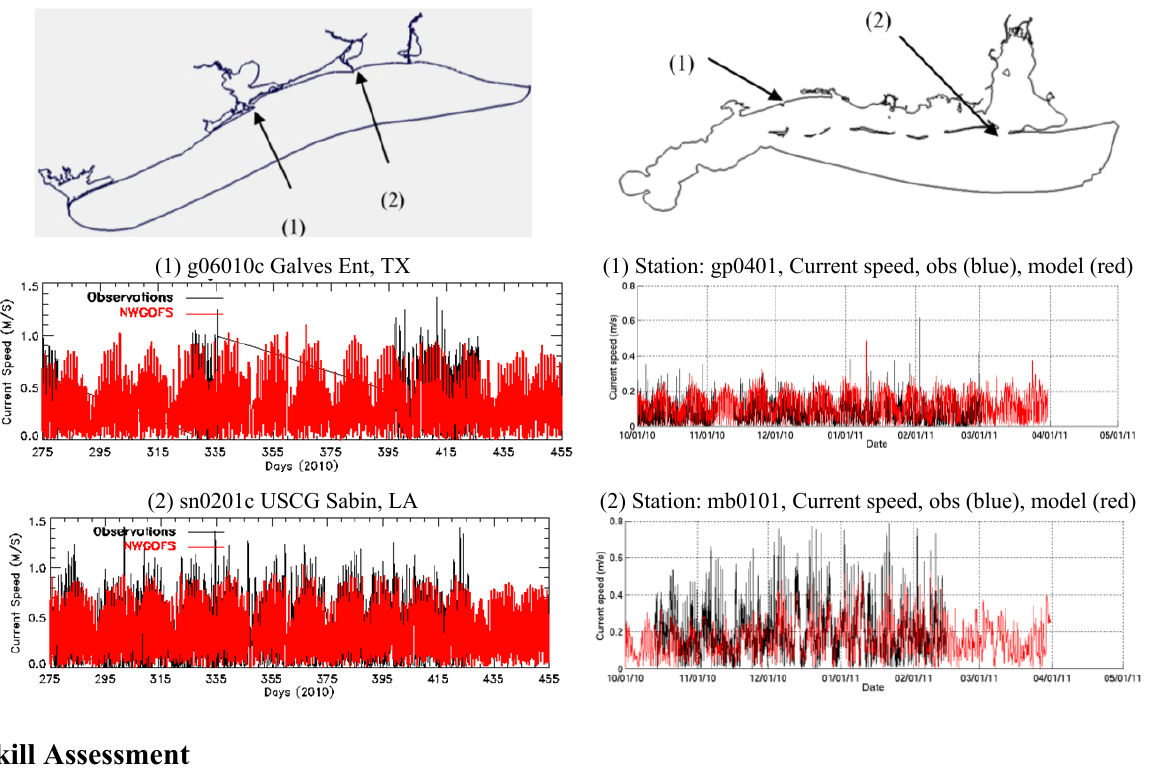
Figure 9. Simulated (red) and observed (black) near surface current speed time series at stations in NWGOFS (left column) and NEGOFS (right column) from 1 October 2010 to 1 April